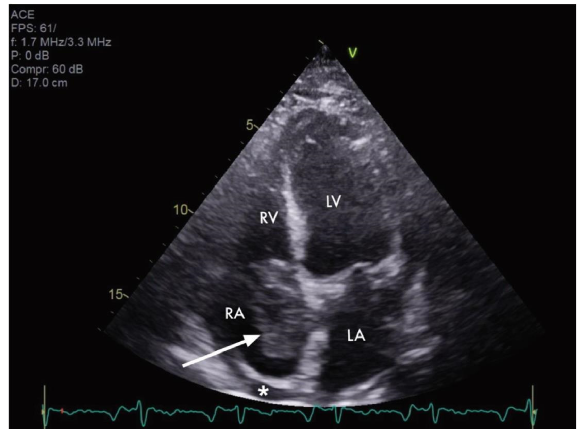
Figure 1: Transthoracic echocardiogram. Apical four chamber view demonstrating a large right atrial mass (arrow) causing tri- cuspid valve obstruction with associated pericardial efusion (as- terisk). Abbreviations: RA (right atrium), RV (right ventricle), LV (left ventricle), and LA (left